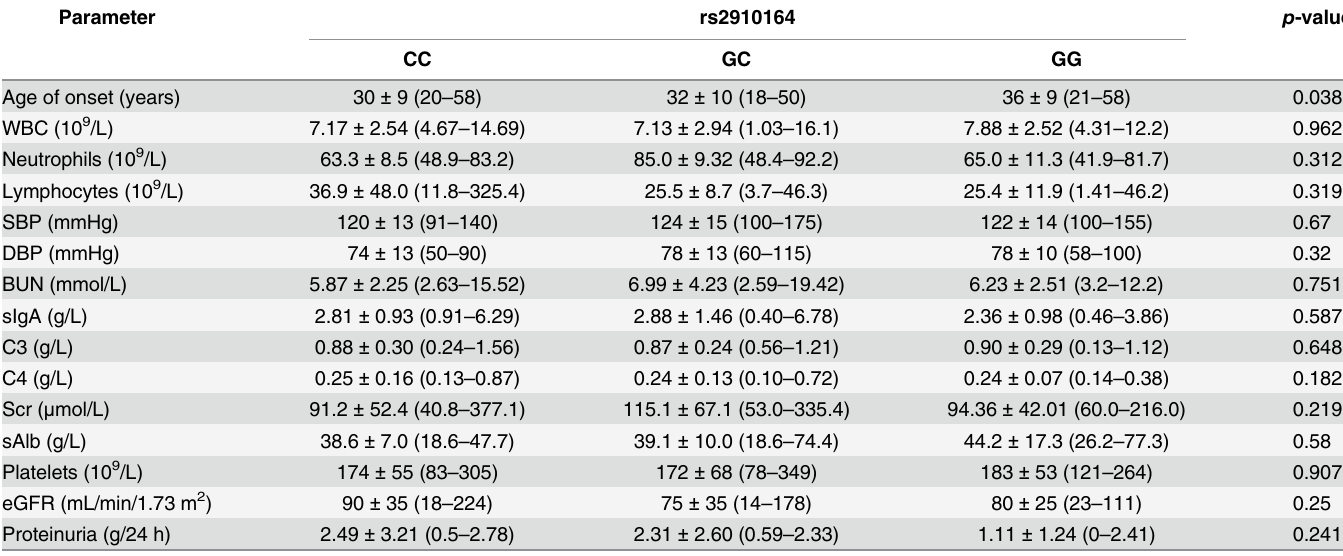
Table 3. miR-146a SNP (rs1946518) genotypes and clinical indexes in IgAN patients. Parameter